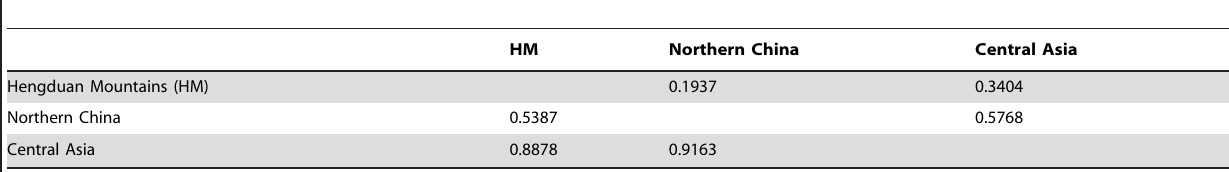
Table 2. Pairwise comparisons of F ST among regions estimated from internal transcribed spacer (ITS) sequences (upper part) and pDNA sequences (lower part) of Rhodiola kirilowii